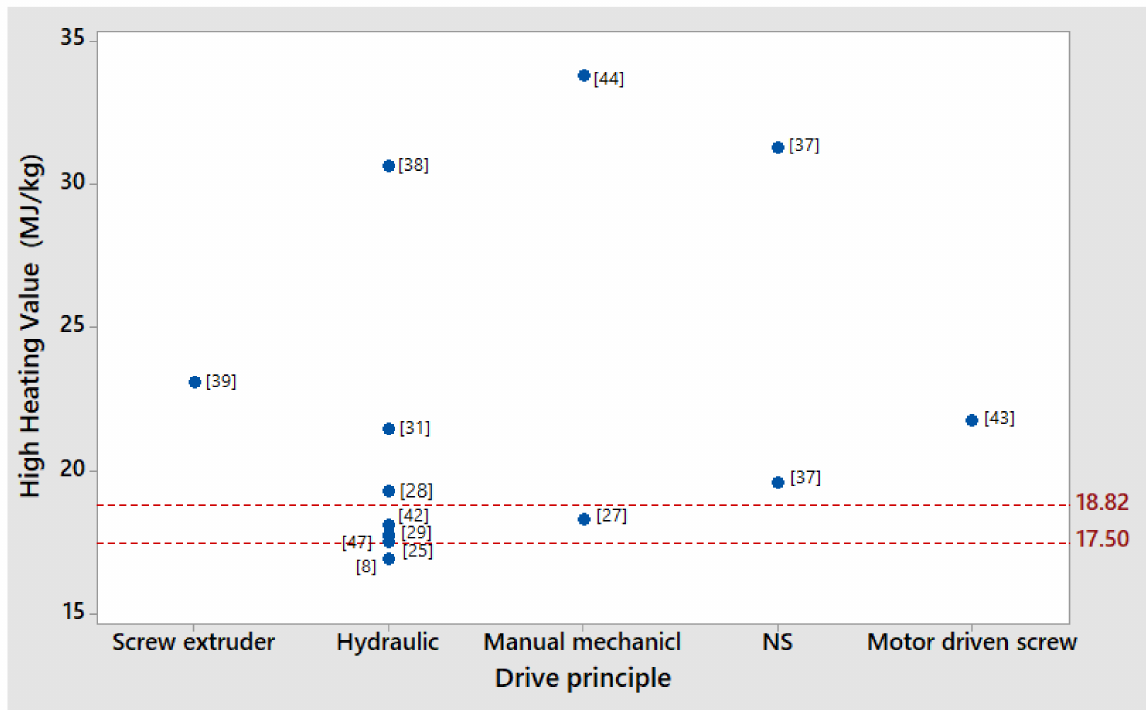
Figure 5. Relationship between the individual values of the high heating value (HHV) with the principle of operation of the briquetting